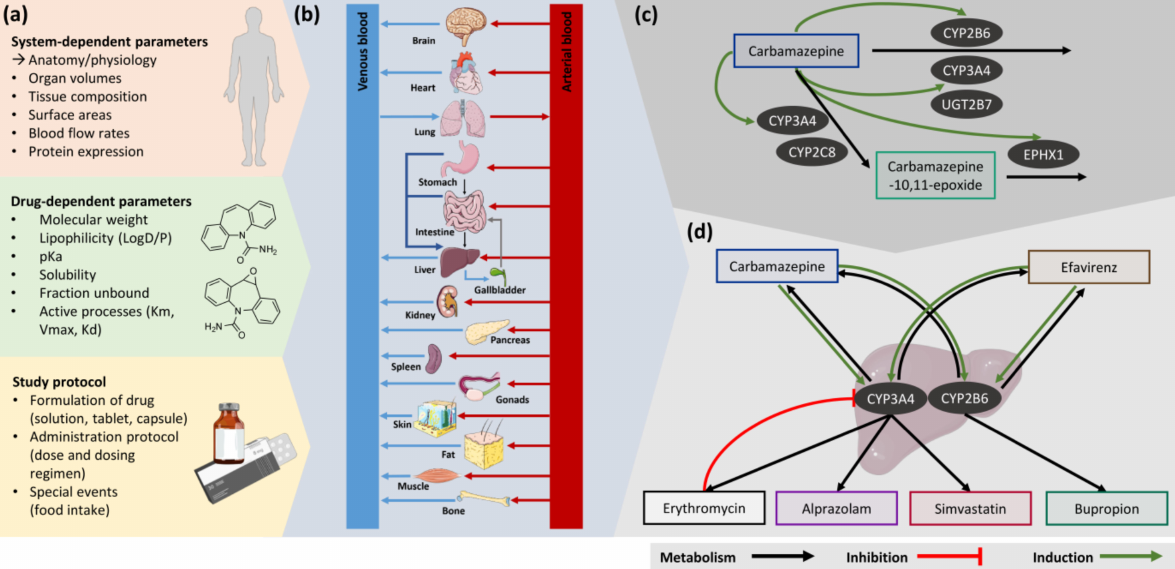
Figure 1. Schematic representation of the PBPK modeling workflow. ( a ) PBPK modeling requires system- and drug- dependent parameters, describing the anatomical and physiological characteristics of the individual and the properties of the simulated compound, respectively. Information on the study protocol of the described clinical study is relevant as well, e.g., formulation and administration of the simulated compound. ( b ) The PBPK model consists of multiple compartments, representing organs of the body, which are connected via the arterial and venous blood flows. ( c ) The final structure of the carbamazepine parent − metabolite PBPK model. ( d ) Overview of the modeled DDIs. Drawings by Servier, licensed under CC BY 3.0 [34]. CYP: cytochrome P450, EPHX1: epoxide hydroxylase 1, K d : dissociation constant, K m : Michaelis − Menten constant, pK a : acid dissociation constant, UGT: UDP-glucuronosyltransferase, V max : maximum